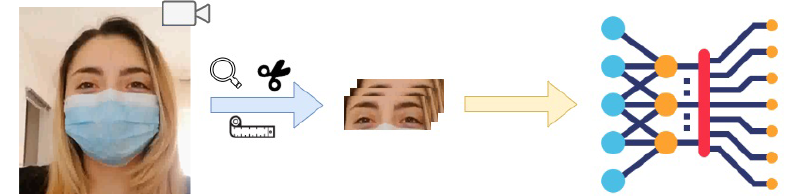
Figure 4. A brief workflow of the face recognition method.